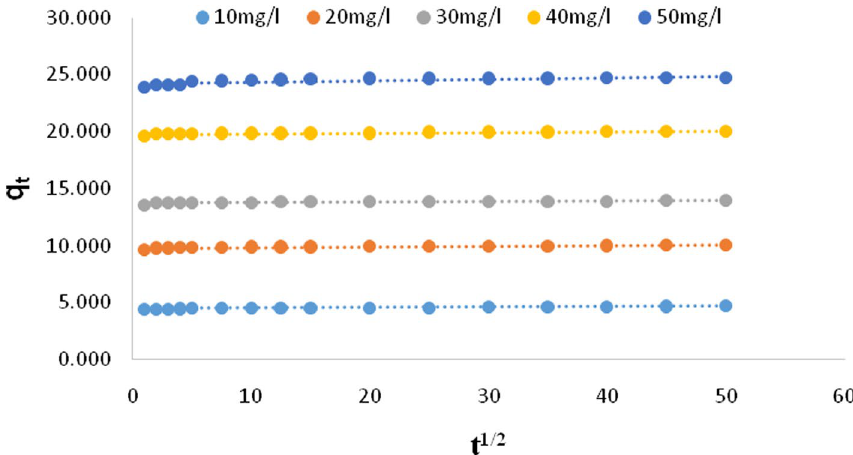
Fig. 5 Plot of intraparticle dif- fusion model of IBP adsorption onto OPA at 30